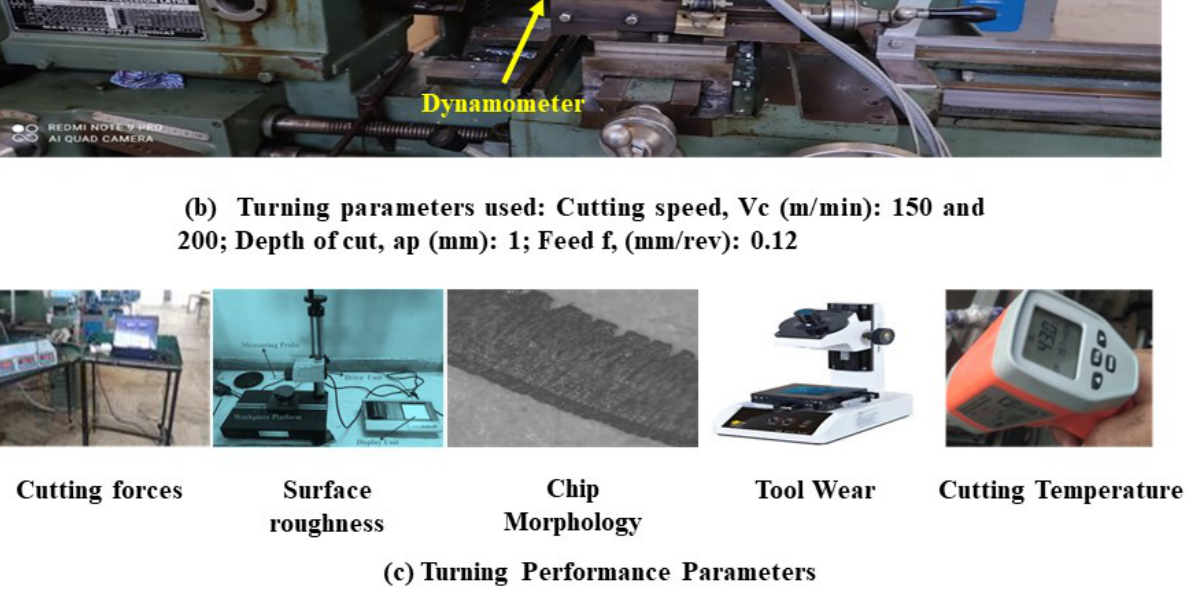
Figure 8. Experimental set-up. ( a ) Environment friendly conditions; ( b ) Turning parameters used: Cutting speed Vc (m/min): 150 and 200; Depth of cut, ap (mm): 1; Feed f, (mm/rev): 0.12 ( c ) Turning performance parameters.